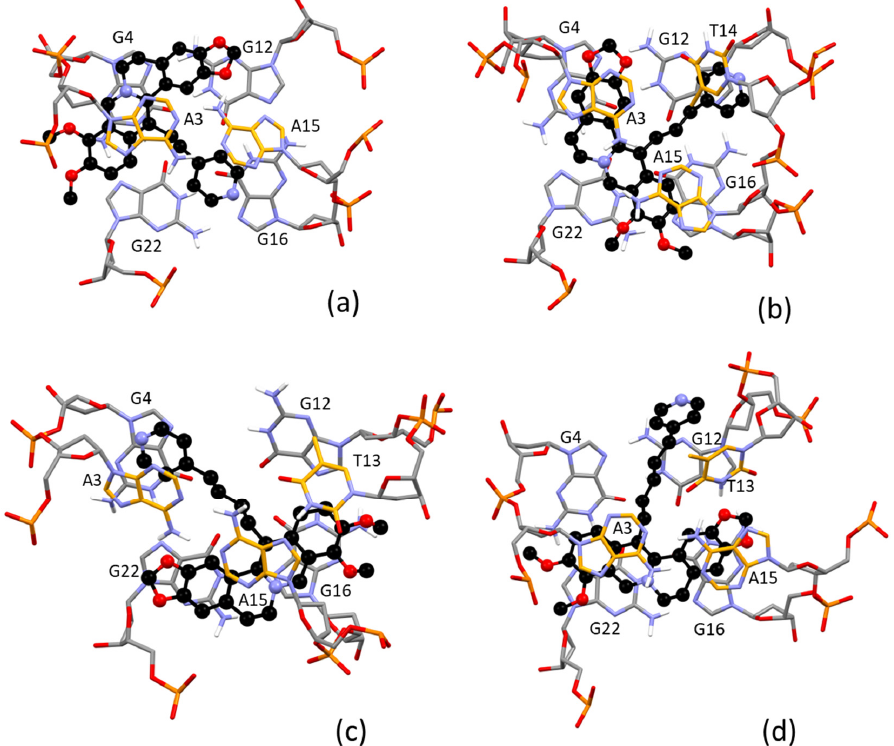
Figure 6. Molecular modeling results for the hybrid ‐ 1 telomeric G ‐ quadruplex/NAX systems: 2 ( a ), 3 ( b ), 4 ( c ) and 5 ( d ) and DNA residues in contact (color code for carbon atoms: ligand = black; guanine = gray; adenine and thymine = light orange). Table 2. Type of interaction and involved residues for the calculated adduct between 2 , 3 , 4 and